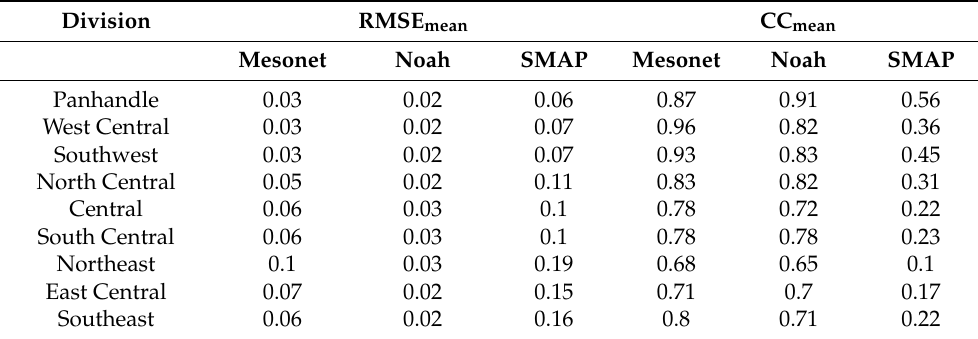
Table 6. Climate-division averaged CC and RMSE from the TC triplets at local 6:00 a.m. from April 2015 to July 2019, for Mesonet, Noah, and SMAP during the summer season months (i.e., June, July, and August) over nine climate divisions in Oklahoma. Division RMSE mean